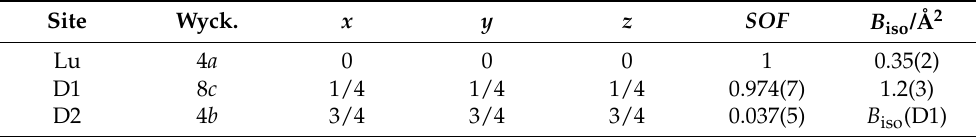
Table A3. The crystal structure parameters of LuD 1.985(19) based on neutron diffraction data at ambient temperature A2 . Wyck.